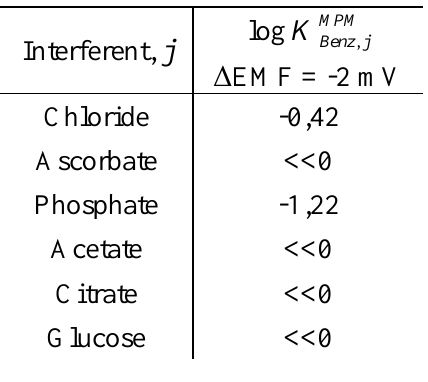
Table 1 . Potentiometric selectivity coefficients of ISEs determined by matched potential